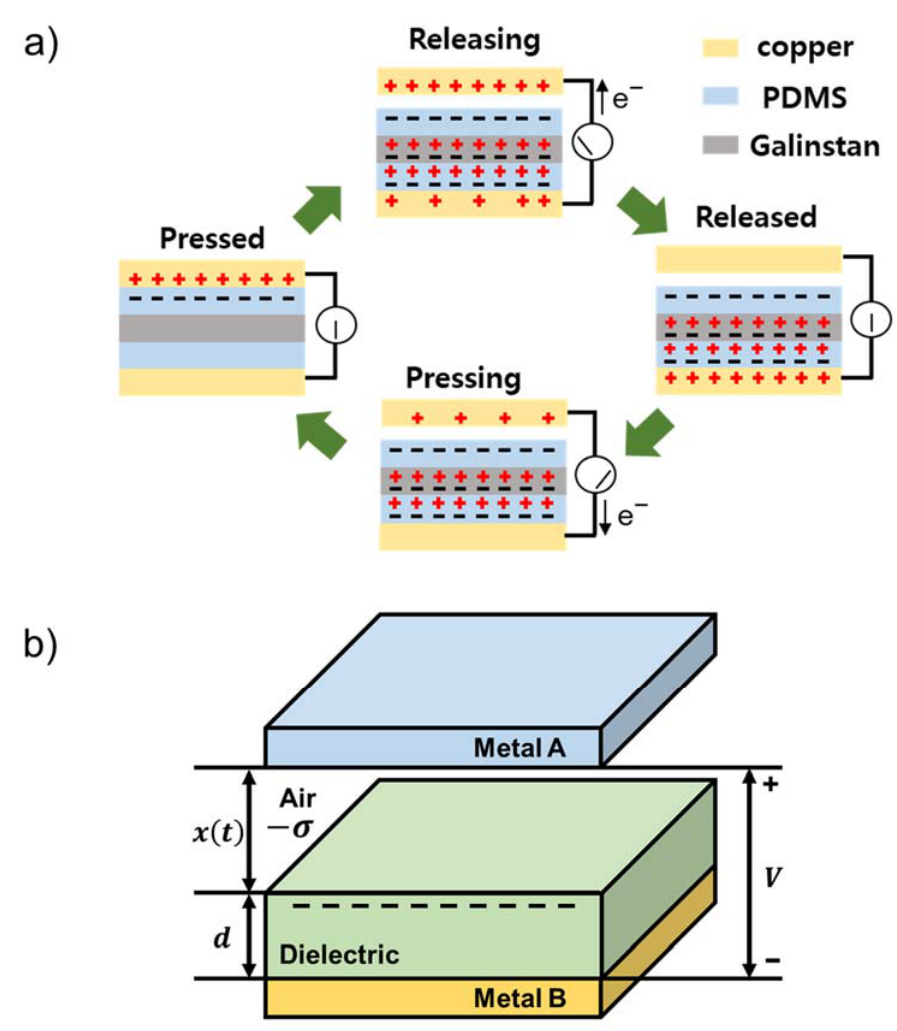
Figure 3. ( a ) The working principle of a TENG with LM/PDMS dielectrics. ( b ) Theoretical models for parallel-plate contact modes for a conductor–dielectric TENG.